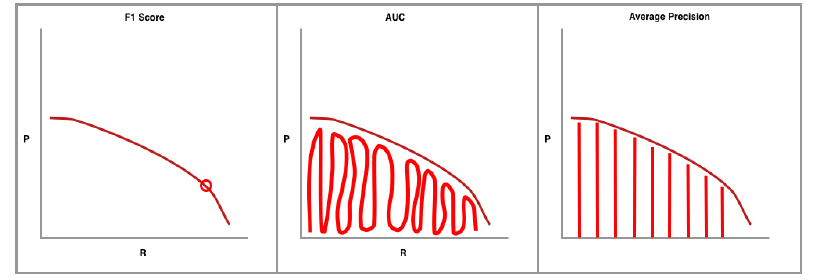
Figure A2. Illustration for F1, AUC and AP metrics [66].